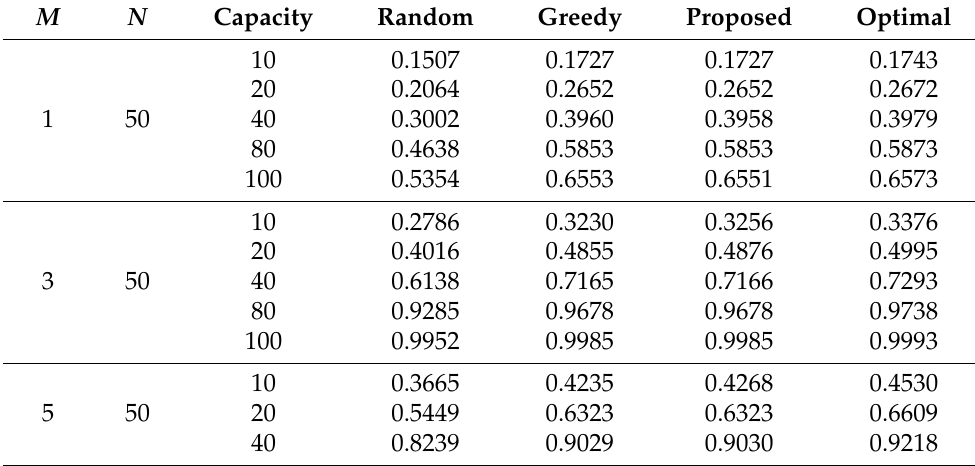
Table 1. Profit ratio of selected items for RI set.